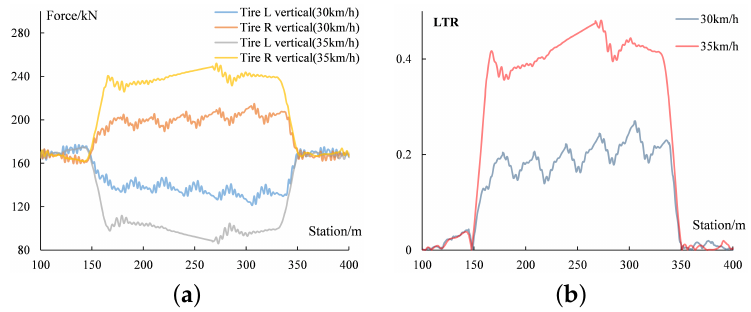
Figure 6. ( a ) Lateral vertical load distribution and ( b ) LTR value of the left and right tire for wind speeds of 62